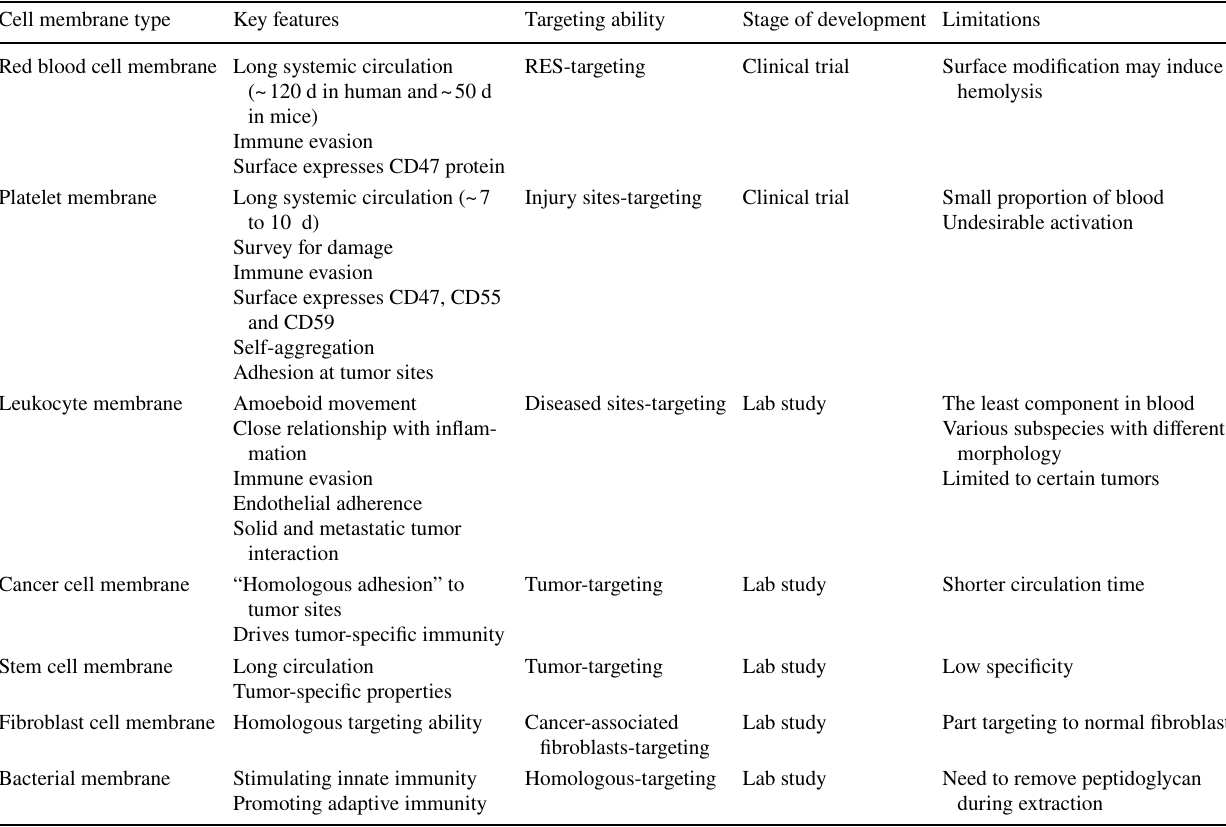
Table 1 Summary of the differences among different cell membrane‑coated NPs Cell membrane